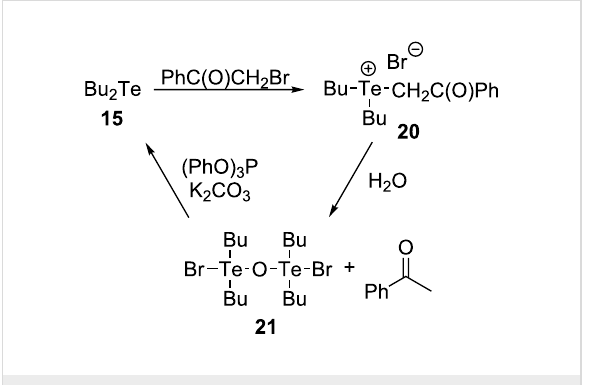
Scheme 6: Stable and odourless telluronium salt pre-catalyst for Wittig-type reactions.